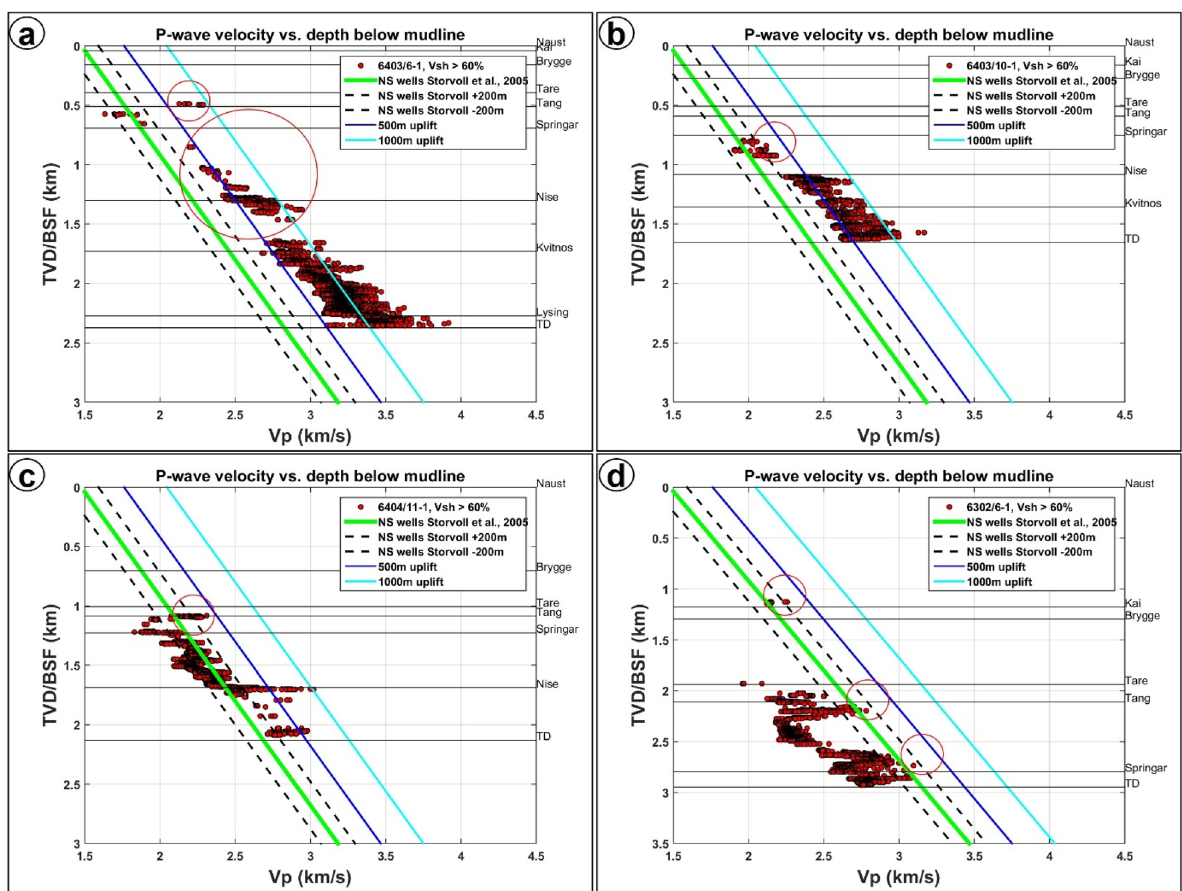
Figure 13. 1D uplift cross plots for wells ( a ) 6403/6-1 ( b ) 6403/10-1 ( c ) 6404/11-1 and ( d ) 6302/6-1. Only well 6403/6-1 shows evidence of uplift and about 400 m to 700 m ± 200 m net erosion within the Springar Formation. Above the Springar Formation, about 750 m to 1000 m uplift is recorded within the Tare Formation. The first three wellbores are in areas where several magmatic sills have been interpreted while 6302/6-1 is outside